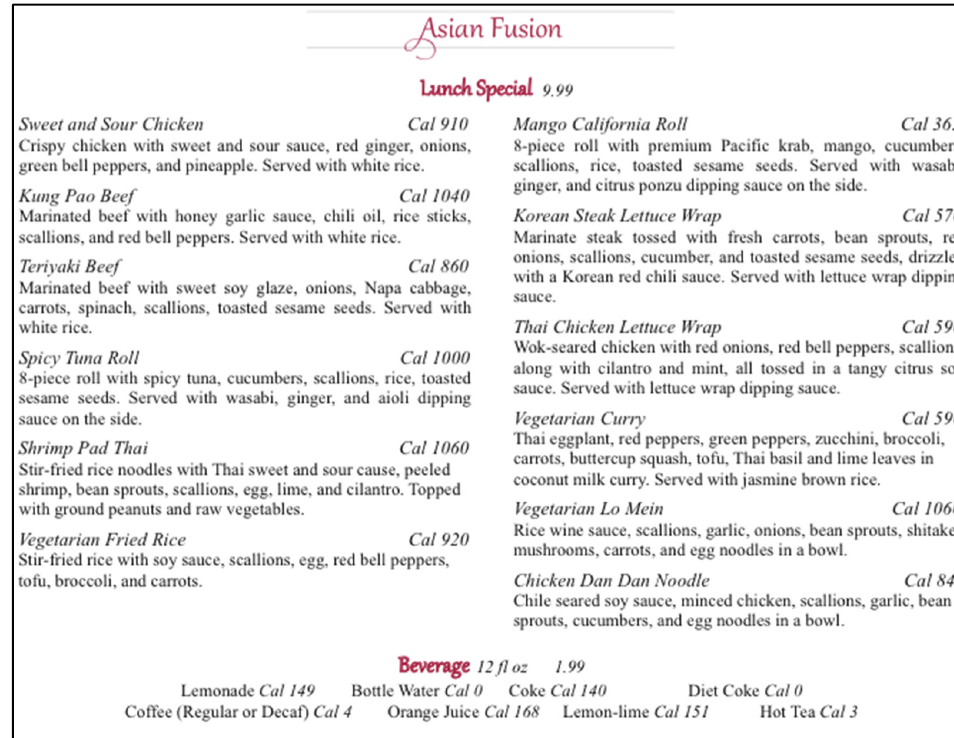
Figure A3. Asian Fusion Sweet Spot Menu.